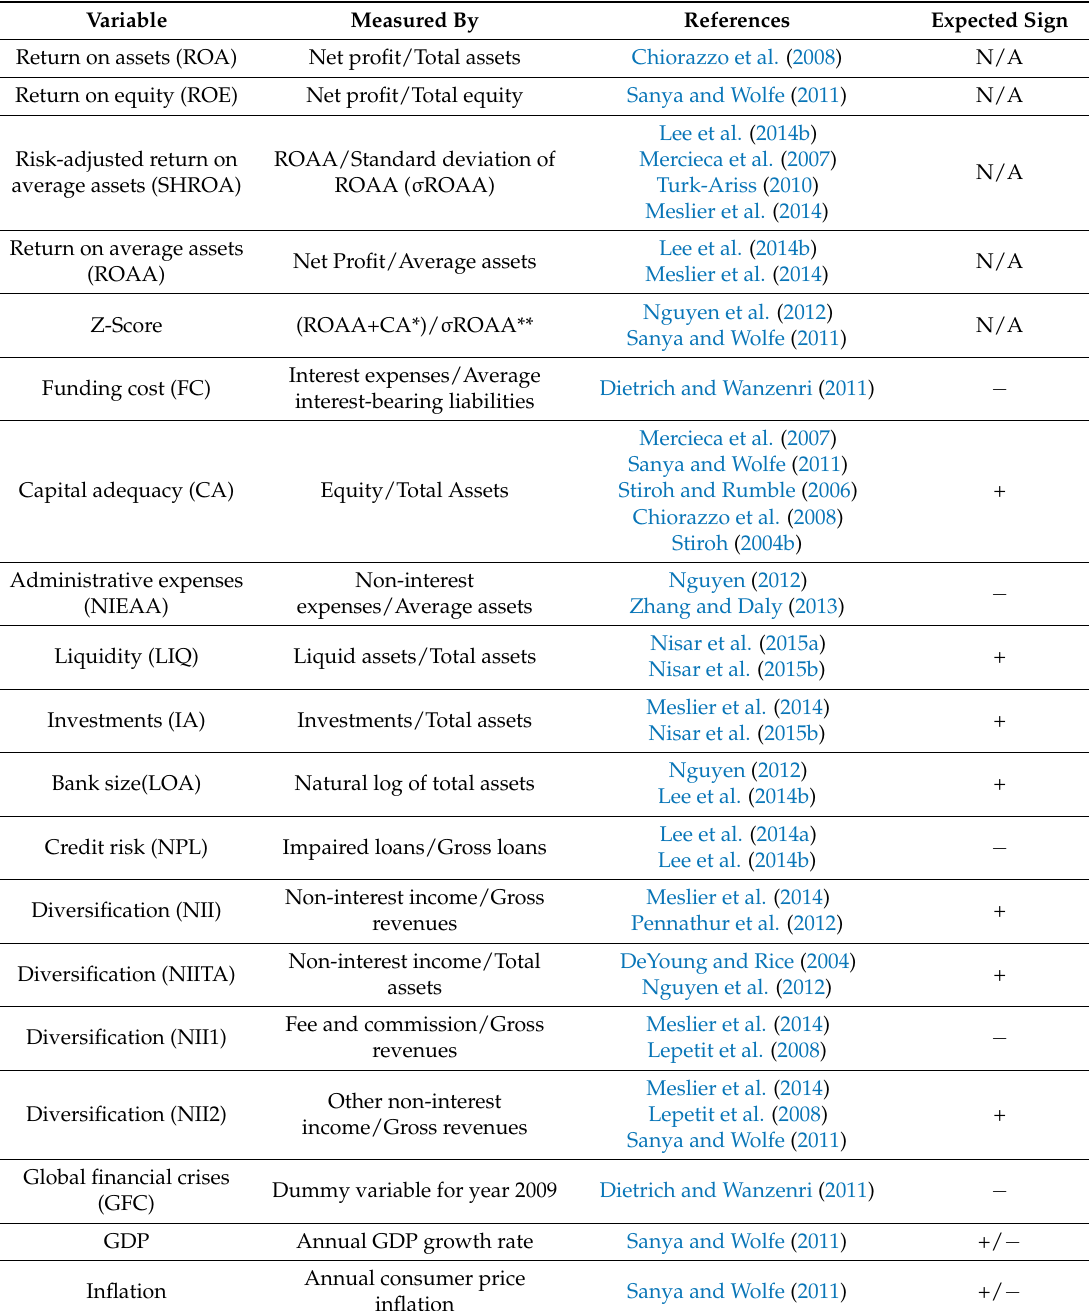
Table 4. Definition and references of dependent and control